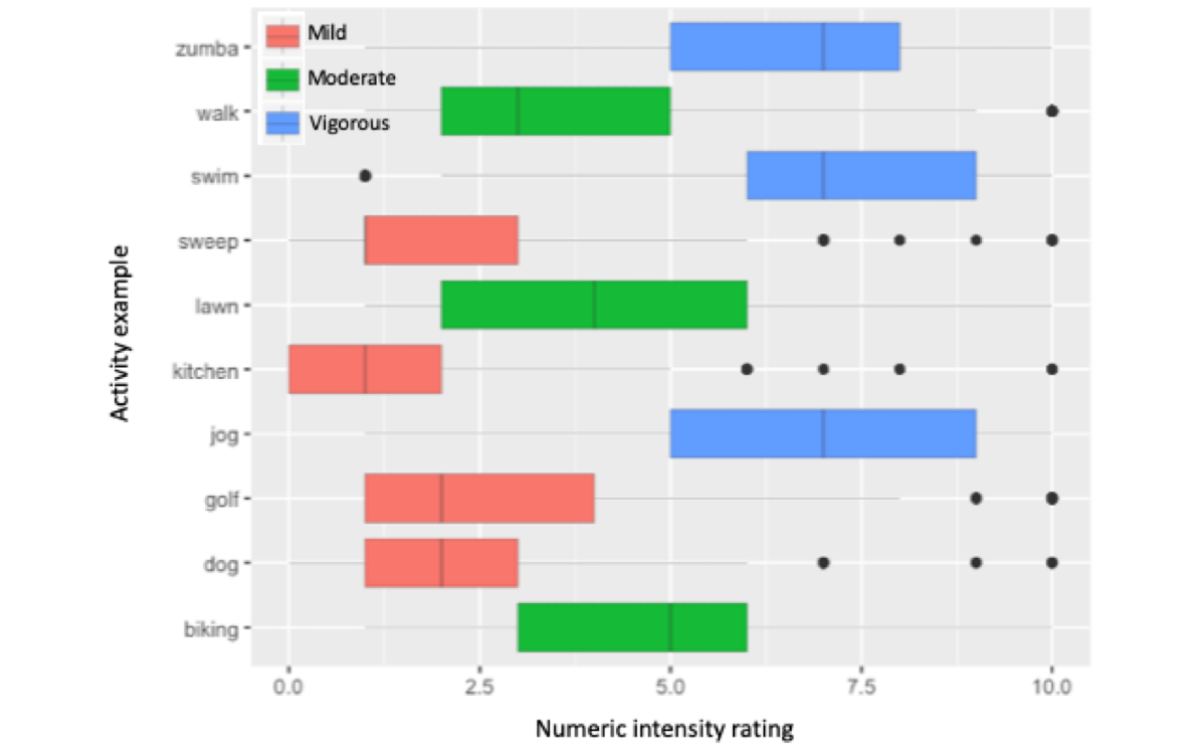
Figure 3. Numeric intensity ratings assigned to 10 activity examples (zumba: aerobic dancing such as Zumba; walk: walking at a pace of 3.5 miles per hour; swim: fast lap swimming–freestyle; sweep: sweeping garage, sidewalk, or outside of the house; lawn: lawn mowing with a hand mower; kitchen: kitchen activities such as cooking, washing dishes, and cleaning up; jog: jogging at a pace of 5 to 7 miles per hour; golf: golf—walking and carrying clubs; dog: walking a dog; and biking: biking at a